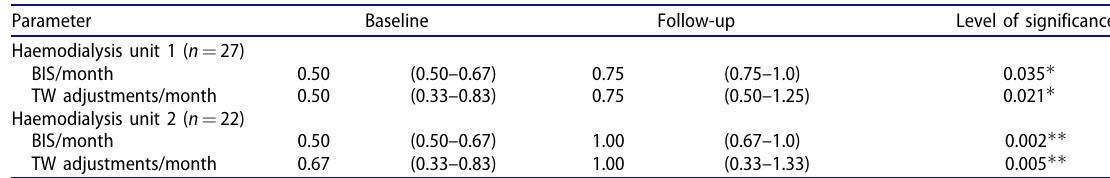
Table 4. Measure of process.